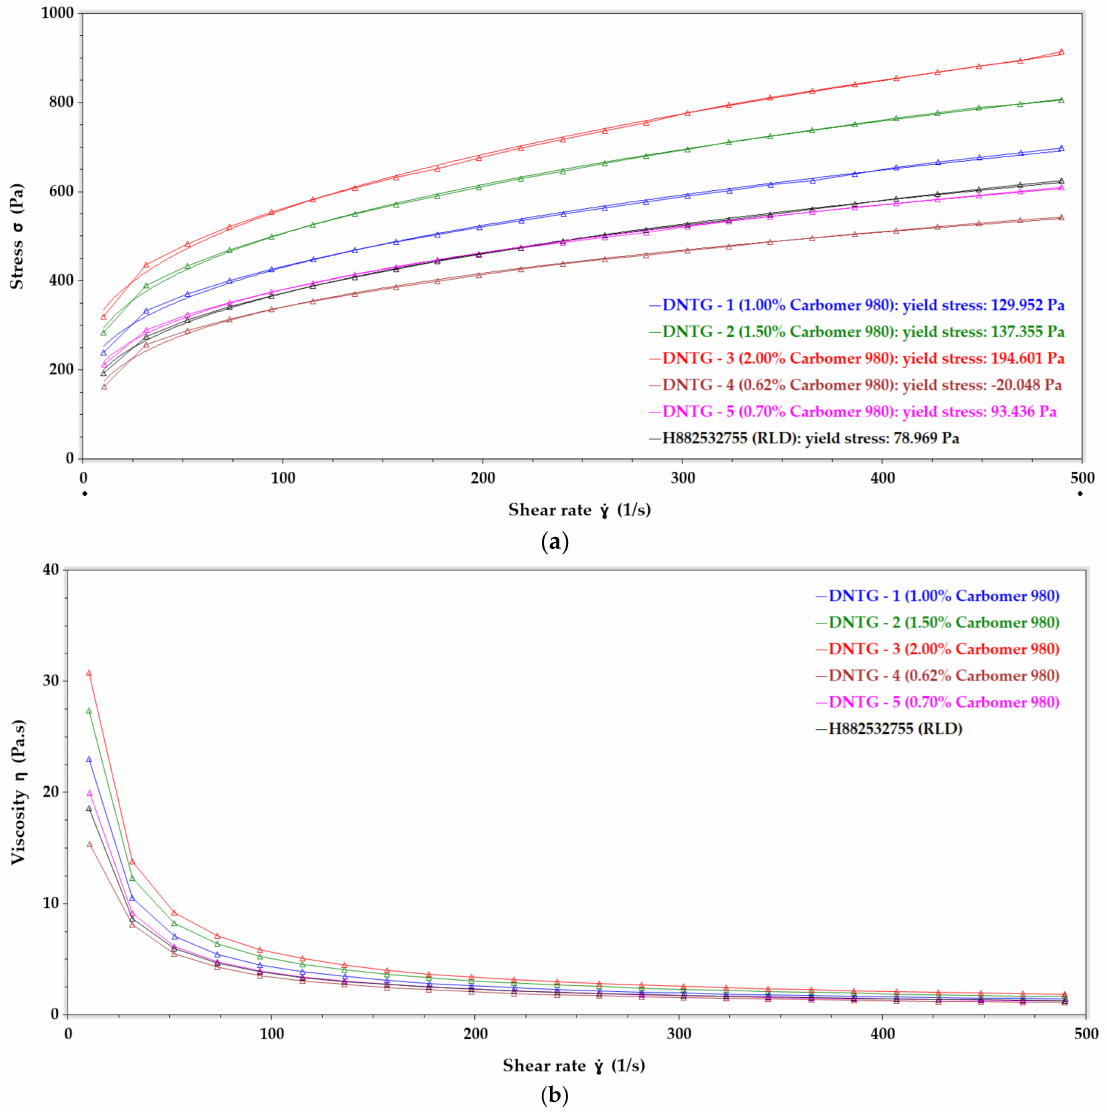
Figure 1. Profile overlay 1 ( a ) Yield stress and 1 ( b ) Viscosity for formulations containing Carbomer 980 concentration 0.62% (DNTG-4), 0.70% (DNTG-5), 1.00% (DNTG-1), 1.50% (DNTG-2), and 2.00% (DNTG-3), and the reference gel prod- uct